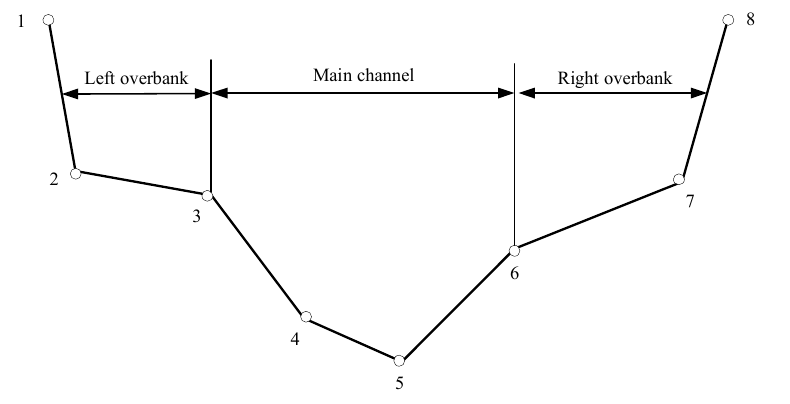
Figure 3. Eight-point cross-section configuration.